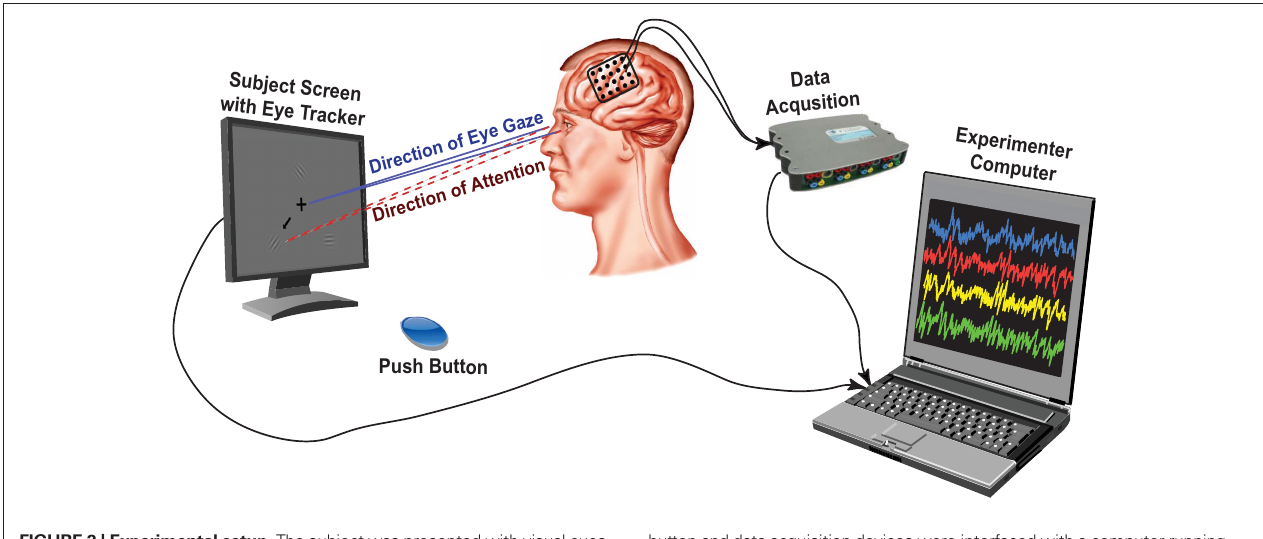
button and data acquisition devices were interfaced with a computer running BCI2000, on which the experimenter could observe recordings and